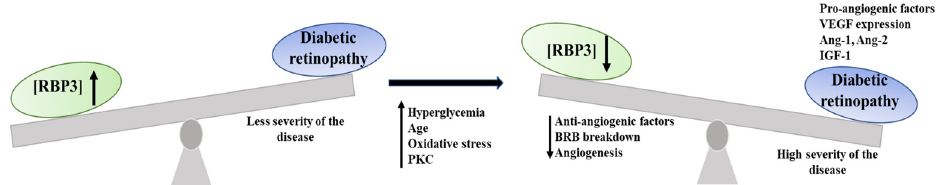
Figure 3. Homeostasis disruption upon DR progression, with decreased levels of RPB3 in the IPM with advances in the severity of DR.